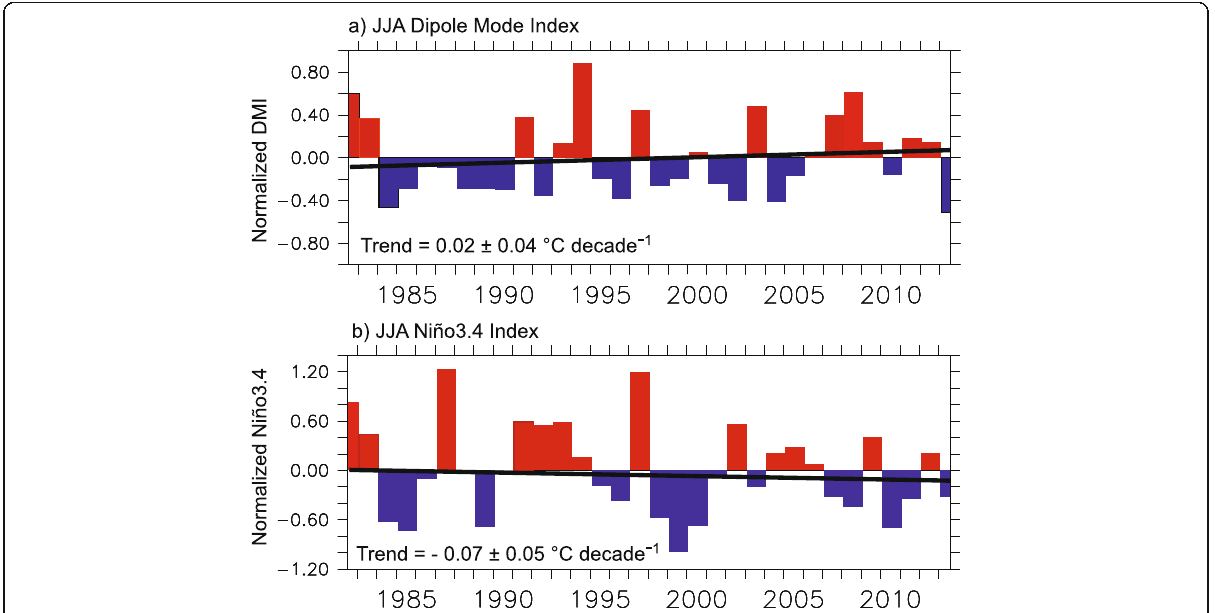
Fig. 5 Normalized a Dipole Mode Index, and b Niño3.4 index during JJA